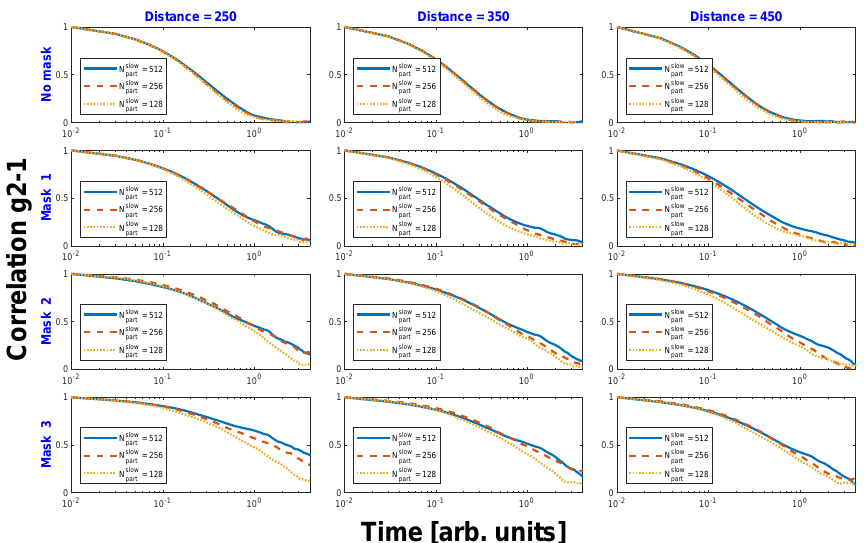
Figure 4. One-time correlation functions obtained with model 3 and three different concentrations (i.e., number of slow particles, N 2 ) in the confined area A 2 , at momentum transfer distances 250, 350 and 450, and for different masks.